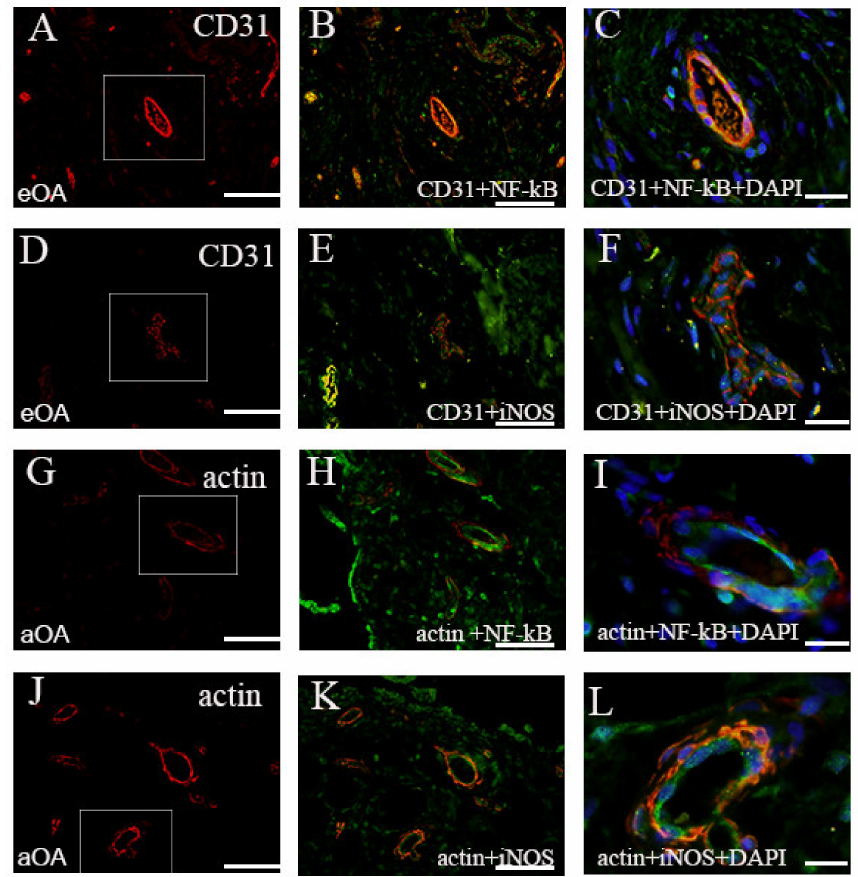
Figure 6. The synovial membrane of patients. CD31 positive cells (red) in the blood vessels (frame) ( A ). CD31+NF-kB+ (merge) in the endothelial cells ( B ). The merge of CD31+NF-kB+DAPI (blue) nuclear; stain ( C ). CD31 positive cells (red) in the blood vessels (frame) ( D ). CD31+iNOS+ (merge) in the endothelial cells ( E ). The merge of CD31+iNOS+DAPI (blue) nuclear stain ( F ). Actin positive cells (red) in the blood vessels (frame) ( G ). Actin+NF-kB+(merge) in the smooth muscle cells ( H ). The merge of Actin+NF-kB+DAPI (blue) nuclear stain ( I ). Actin positive cells (red) in the blood vessels (frame) ( J ). Actin+iNOS+(merge) in the smooth muscle cells ( K ). The merge of Actin+iNOS+DAPI (blue) nuclear stain ( L ). eOA—early OA; aOA—advanced OA. Magnification × 40 (first two columns), scale bar 50 µ m and × 100 (last column), scale bar 20 µ